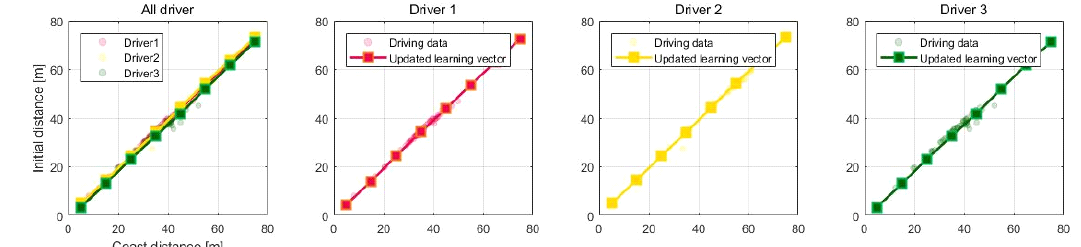
Figure 20. Learning results of learning vector for initial distance.